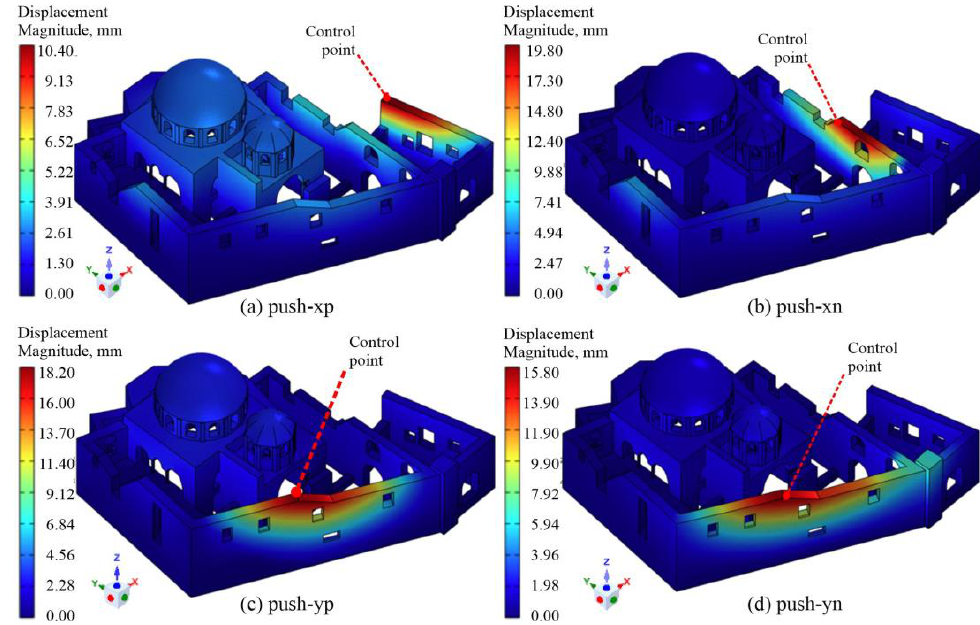
Figure 21. Displacement contours of the perimeter walls at ultimate strength under lateral loads.